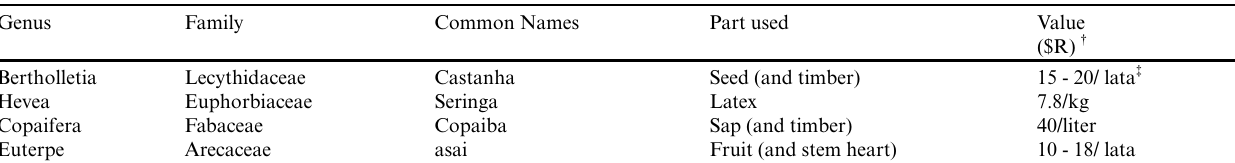
Table 3 . Nontimber forest product species, common names, and examples of 2012 market values from Acre, Brazil.